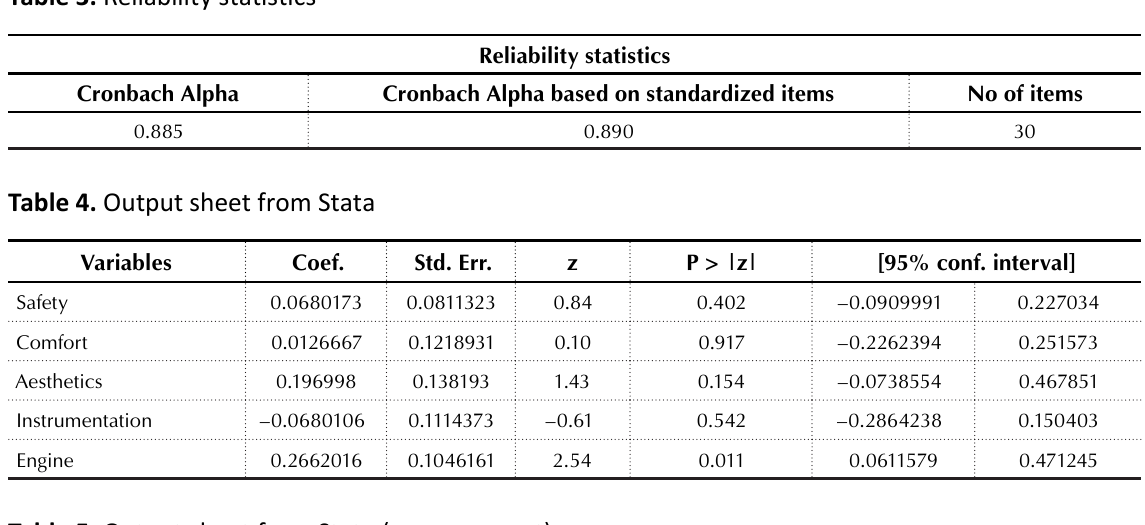
Table 5. Output sheet from Stata